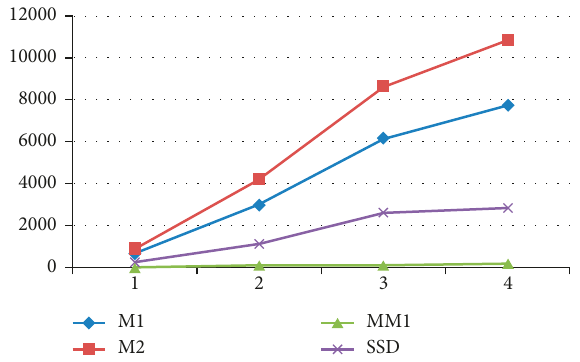
Figure 4: Comparison of computed TIs of (TM-TCNB) 1 .